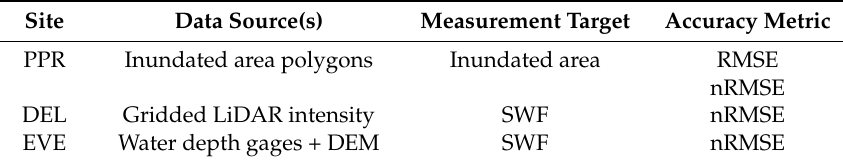
Table 4. Summary of data source and target measurements for algorithm assessment at each of the three study sites (PPR, Prairie Pothole Region; DEL, Delmarva Peninsula; EVE, Everglades).